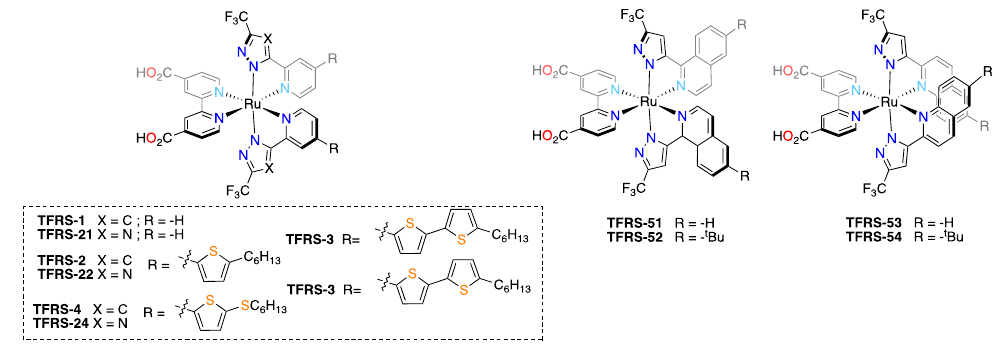
Figure 9. Some of the TFRS series sensitizers with bidentate ligands. Table 3. Photovoltaic performance of selected TFRS series sensitizers with bidentate